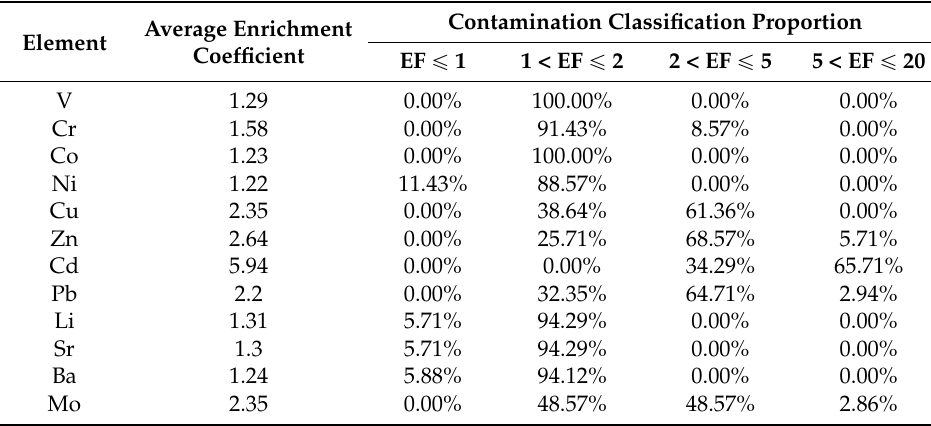
Table 5. Proportion of contamination classification of metal elements in the